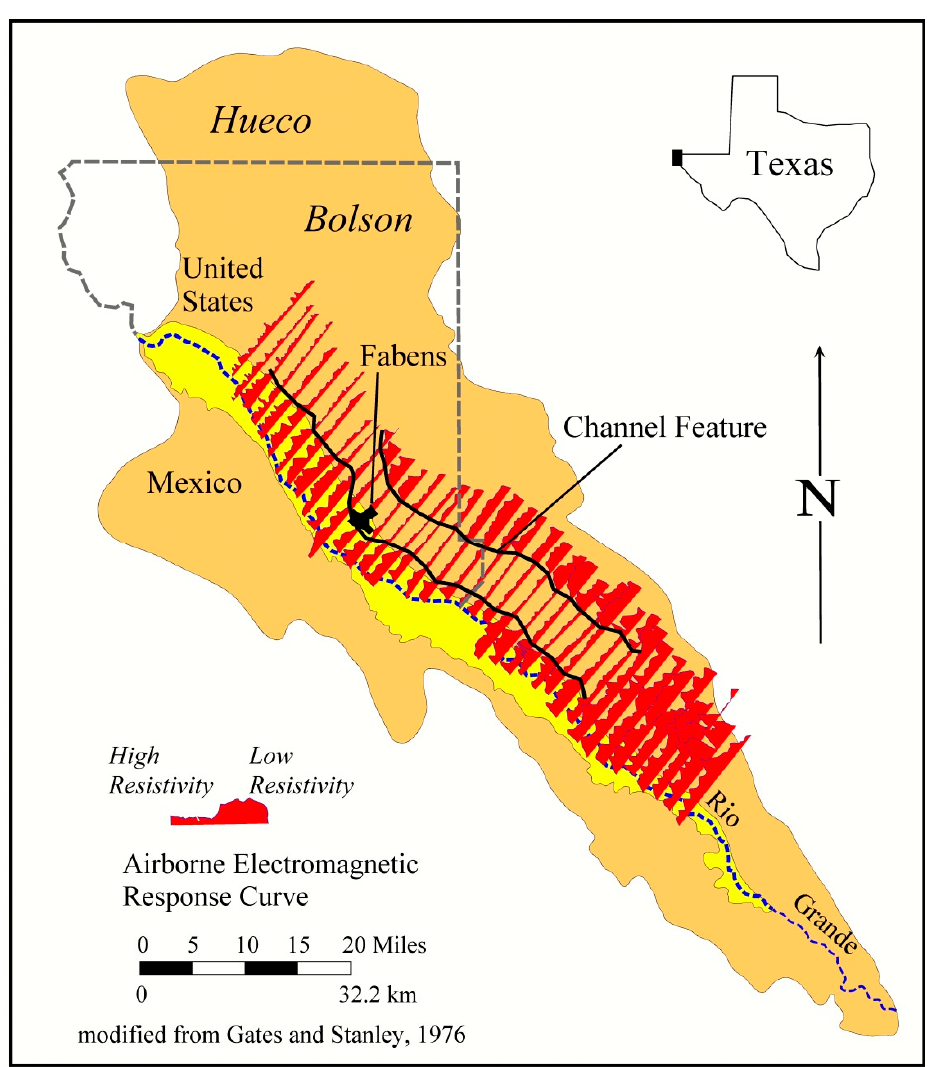
Figure 8. Airborne geophysical mapping by Gates and Stanley [11] identified a buried channel in the vicinity of Fabens. They interpreted this channel as part of the upper Camp Rice Formation formed by the ancestral Rio Grande.